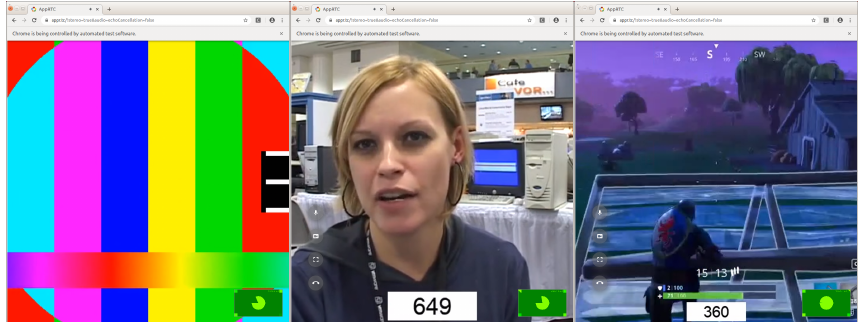
Figure 3. Screenshots of AppRTC during the test execution while playing padding sequence, conversational-type reference, and game reference,